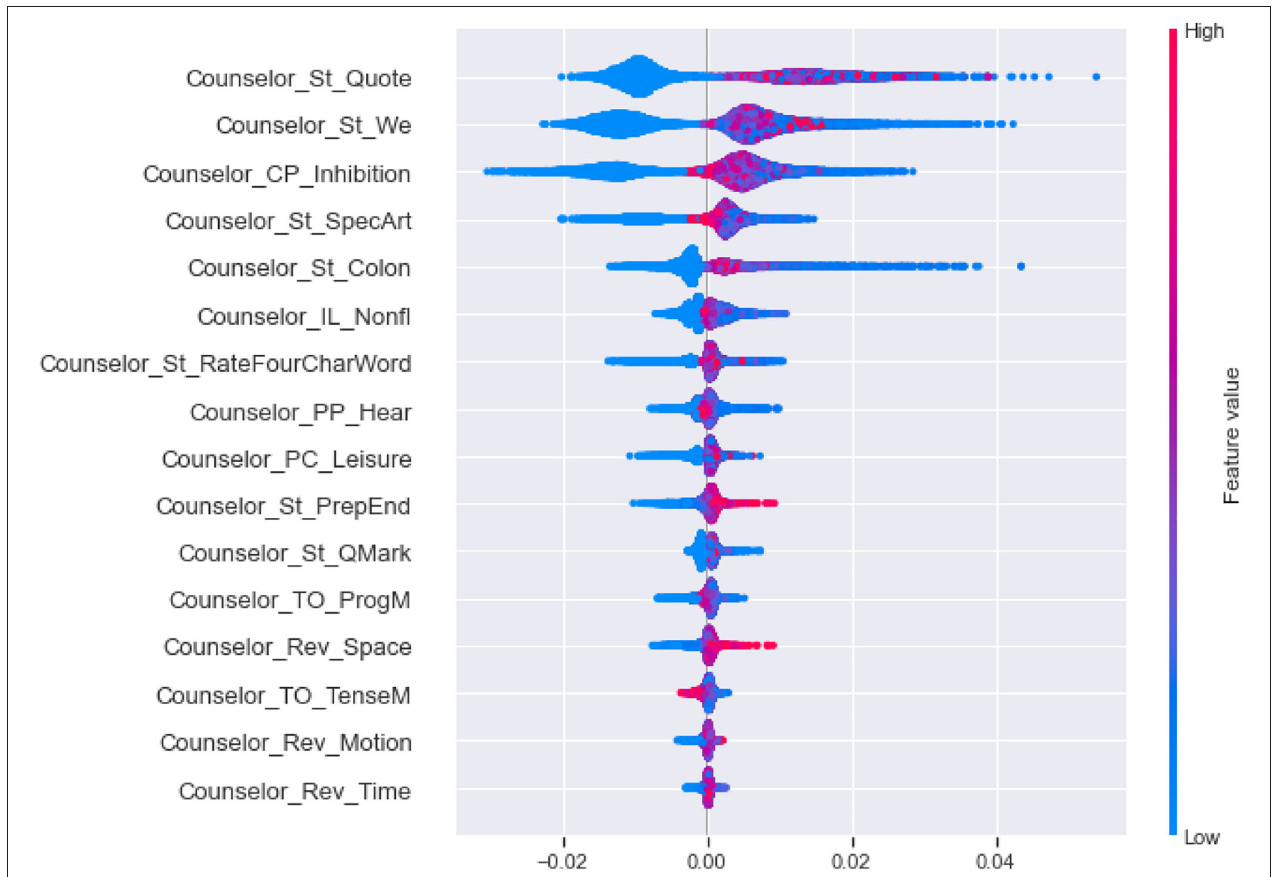
FIGURE 7 | The SHAP summary plots about the adjustment to the predicted in perceived helpfulness numbers (x-axis) for each of the fourth type features.